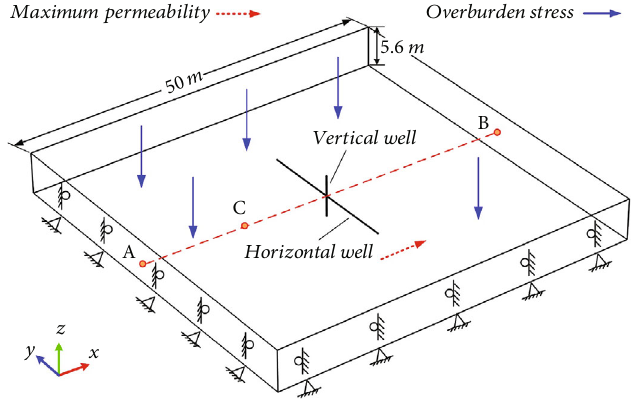
Figure 13: Geometric model for numerical